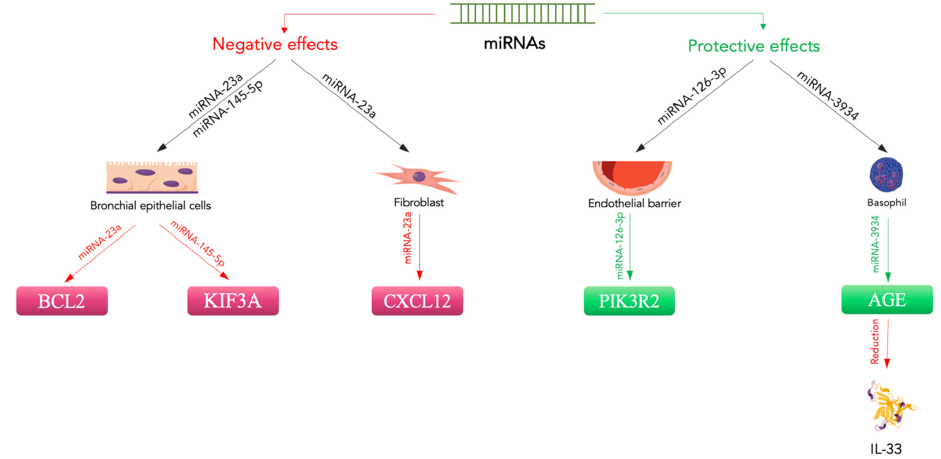
Figure 2. Protective and negative effects of miRNAs on asthma. MiRNA-23a downregulates CXCL12 expression in fibroblasts [122]. In bronchial epithelial cells, it negatively regulates BLC2 expression, while miRNA-145-5p suppresses KIF3A [121,122]. These miRNAs promote bronchial inflammation and disease exacerbation. In contrast, protective effects are related to the action of miRNA-126-3p on the endothelial barrier through PIK3R2 [127]. Additionally, miRNA-3934 acts to mitigate IL-33 levels [123]. Magenta indicates downregulation, green indicates upregulation.